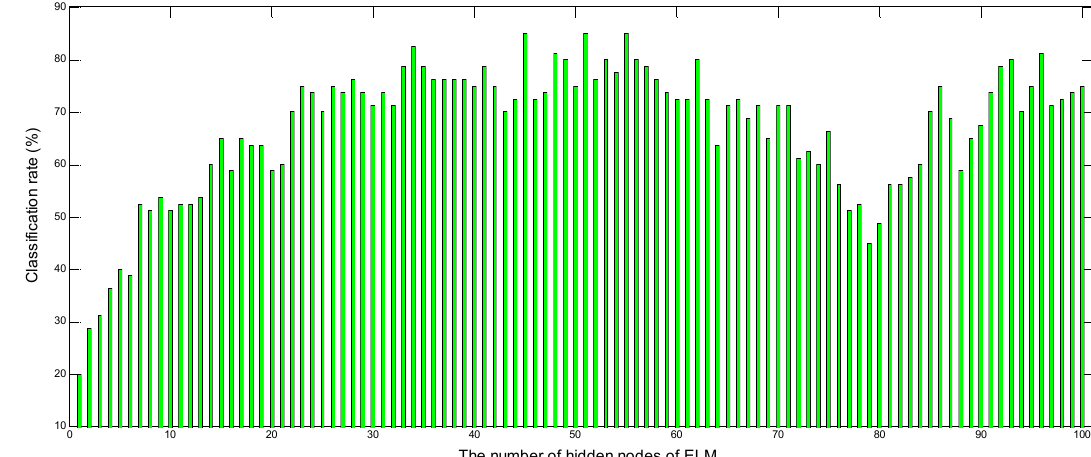
Figure 4. The performance of ELM according to the number of hidden nodes from 1 to 100.